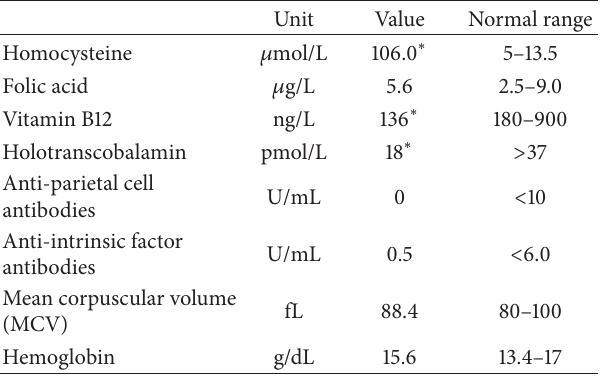
Table 1: The laboratory results showing typical changes indicating vitamin B12